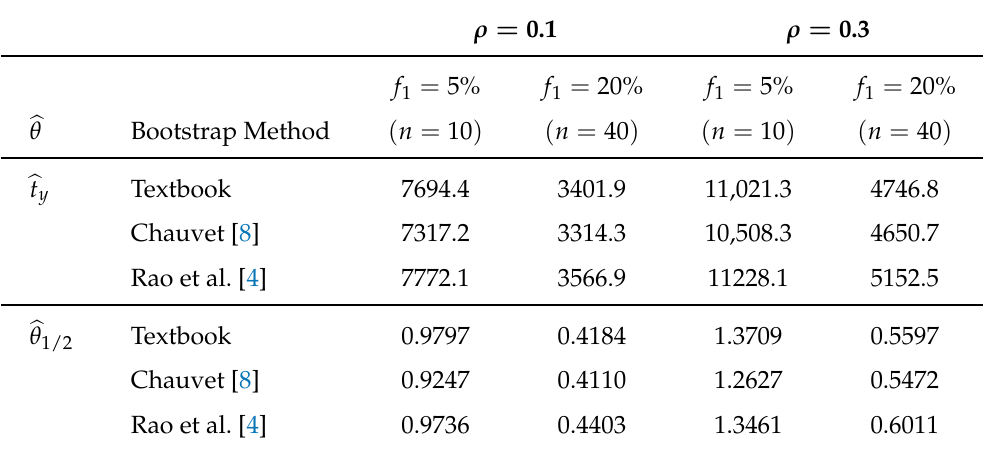
Table 9. Average length (AL) of the 95% t -distribution based confidence intervals constructed using bootstrap standard error estimators based on 3000 samples selected according to